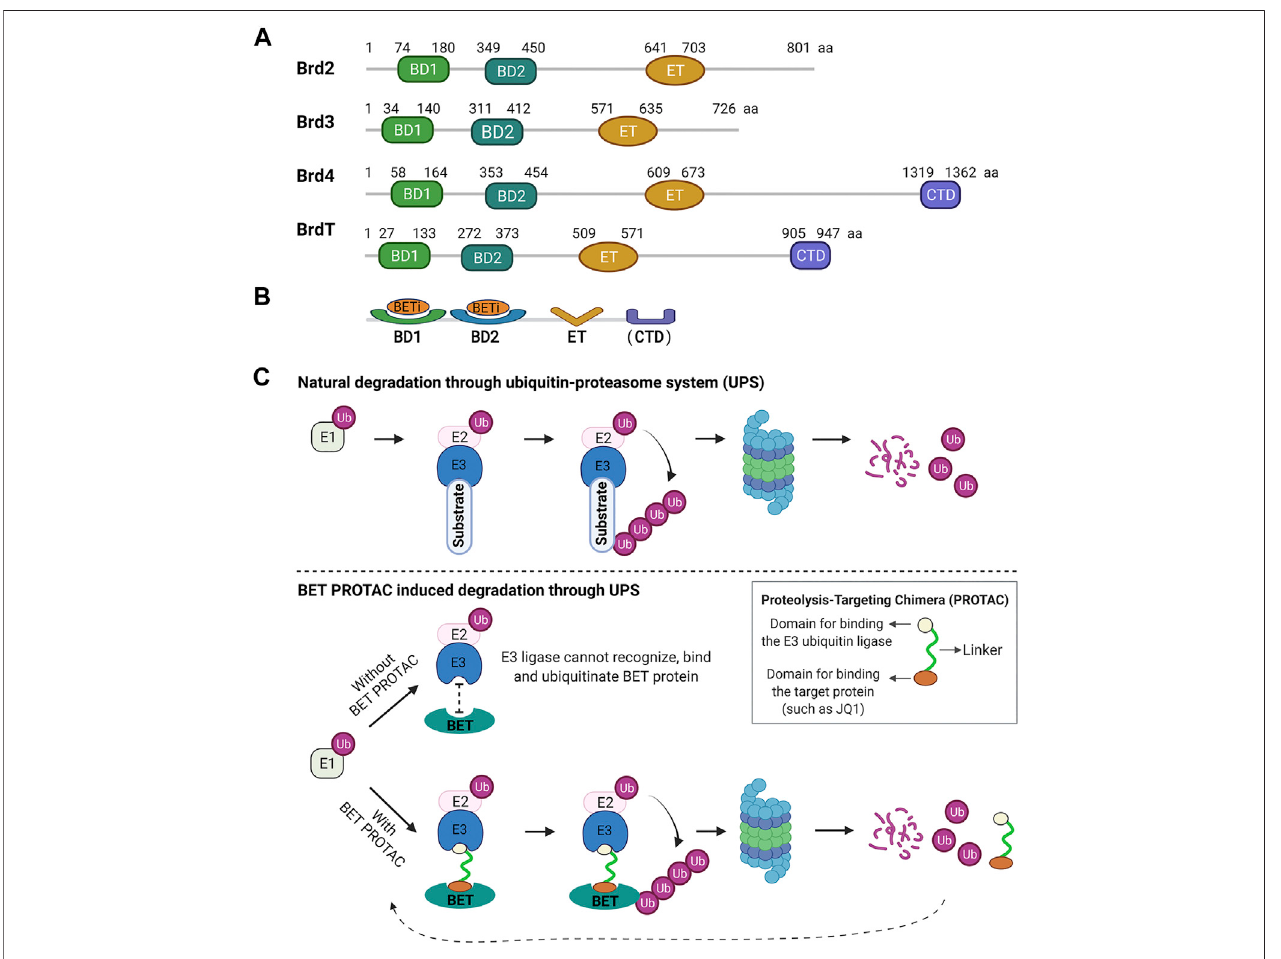
FIGURE 1 | Human BET family structural domains and mechanisms of inhibition. (A) Structural domains of BET proteins. All BET proteins share two tandem N-terminal bromodomains (BD1 and BD2) and an extra-terminal (ET) domain. In addition, Brd4 and BrdT contain a unique C-terminal domain (CTD). The numbers refer to the amino acid boundaries of each domain for the human BET proteins. The alignment of amino acid (aa) sequences is from the public protein sequence database, GenPept, NCBI Reference Sequence: Brd2, NP_005095.1; Brd3, NP_031397.1; Brd4, NP_490,597.1; BrdT, NP_001229734.2. (B) To date, all reported BET inhibitors (BETis) target BDs on BET proteins. (C) BET PROTAC mechanism. The E1 enzyme activates ubiquitin (Ub) and initiates its transfer to a target substrate through the E1-E2-E3 cascade. Then, the target substrate tagged by ubiquitin is degraded by the proteasome. Without BET PROTAC, BET protein is not recognizable for the ubiquitination process. BET PROTAC molecules can bind the target BET protein and the E3 ubiquitin ligase together, and such binding ubiquitinates the target protein, making it available for subsequent proteasomal